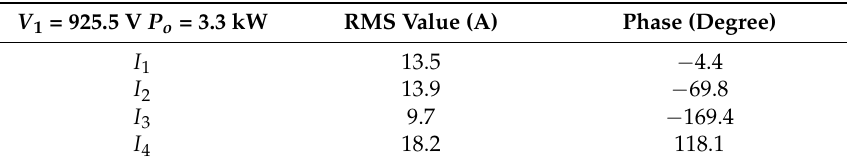
Table 3. Currents in WPT coils. RMS: root mean